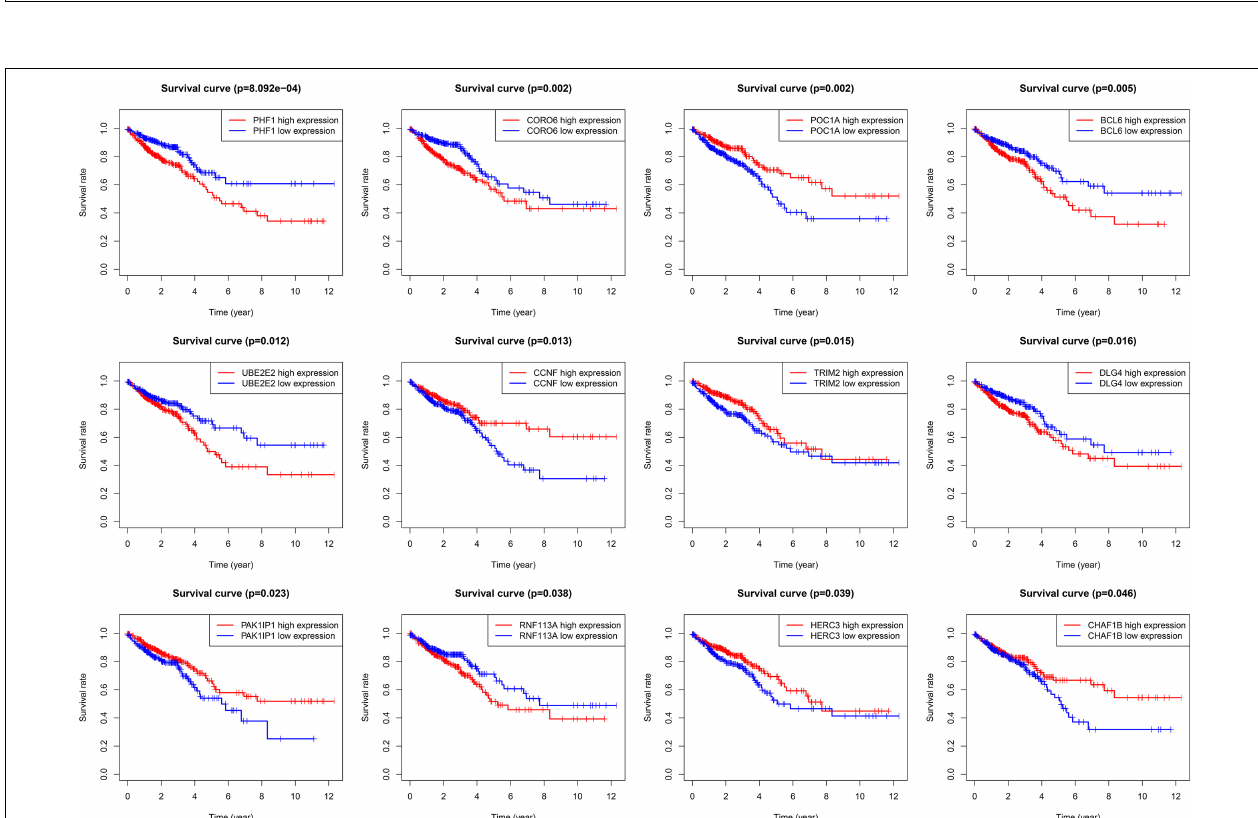
FIGURE 4 | Kaplan–Meier plots of 12 overall survival-related differentially expressed UPS-associated genes.